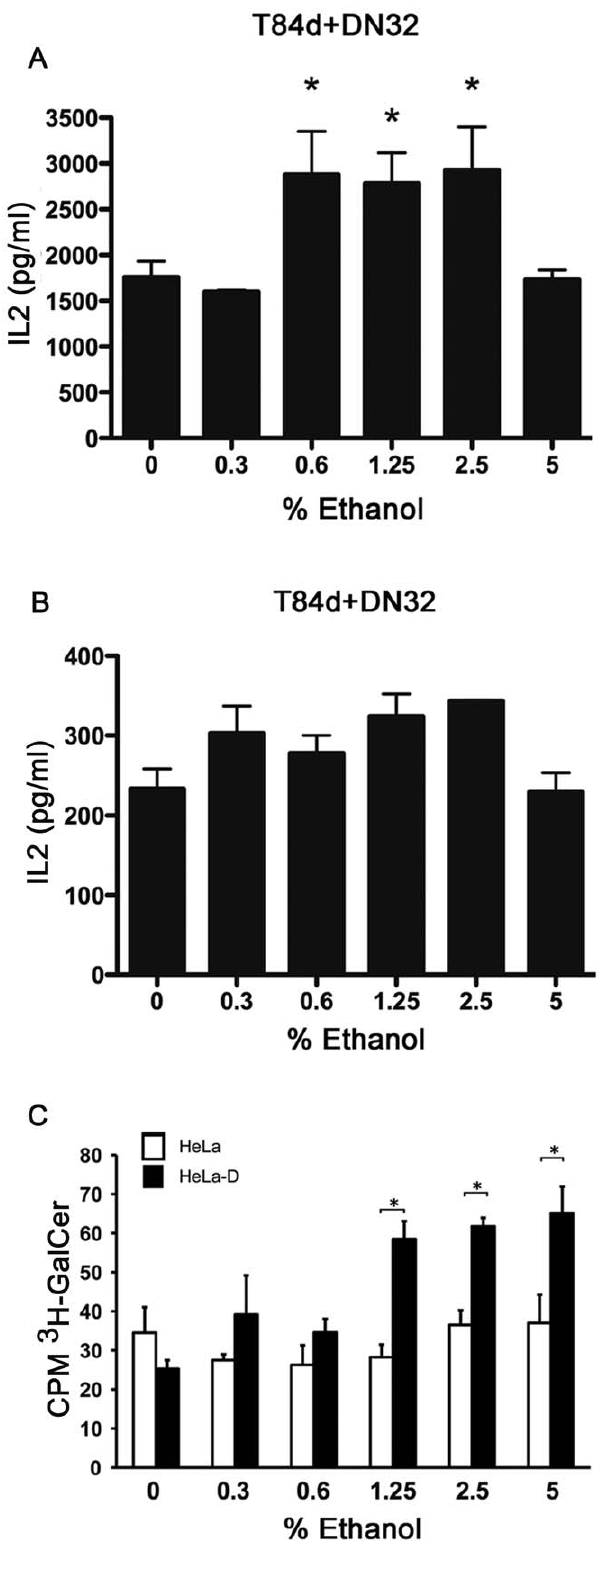
Figure 1. Low levels of ethanol stimulate activation of NKT cells via enhanced CD1d antigen loading. A) T84d cells were loaded with a GalCer in combination with different concentrations of ethanol. The next day these cells were incubated with DN32 NKT cells and the production of IL-2 was measured after 24 hours. B) T84d cells